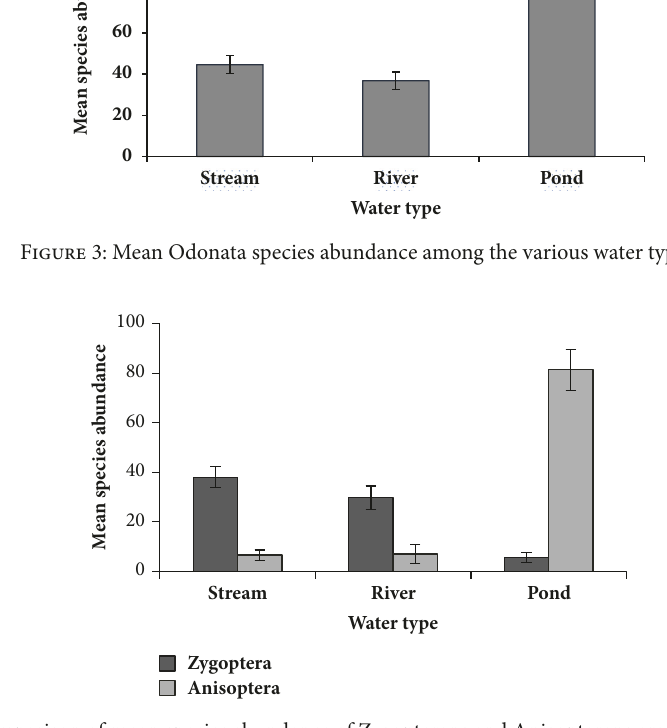
those with steeper curves were less diverse (Figure 6).